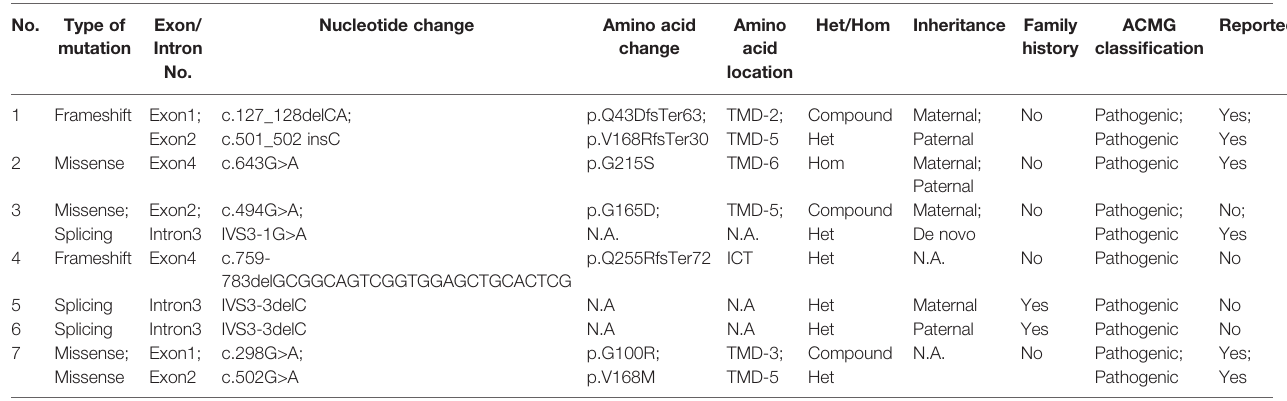
TABLE 1 | Mutation analysis of AQP2 in patients with